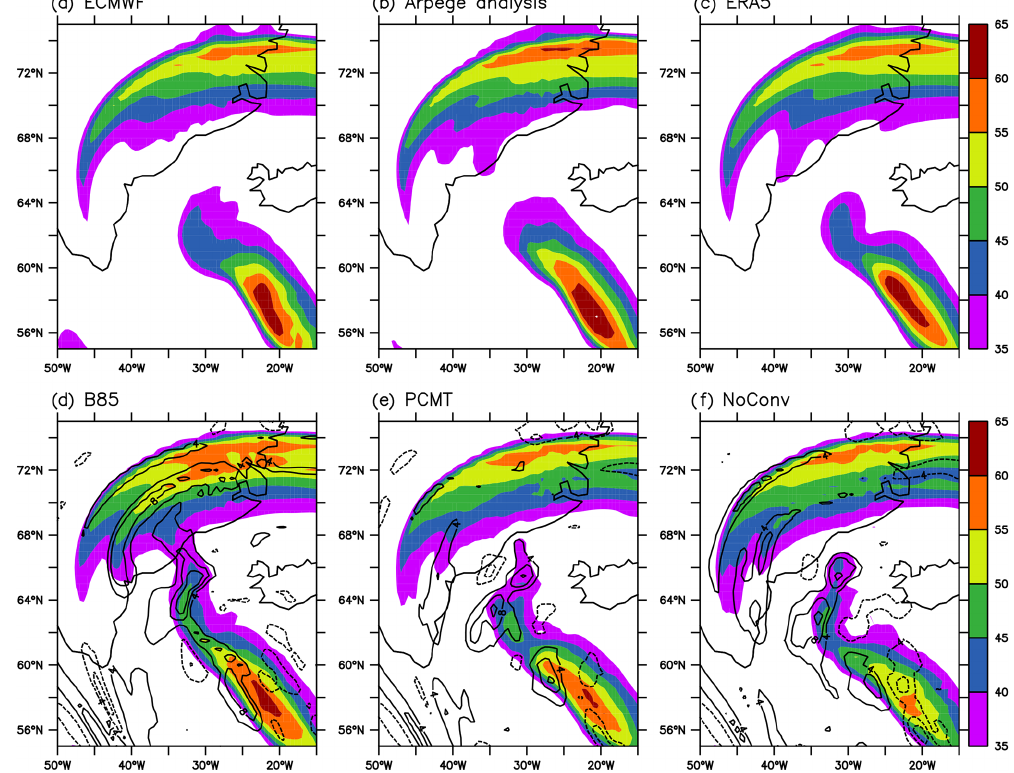
Figure 10. As in Fig. 9 but at 18:00UTC on 2